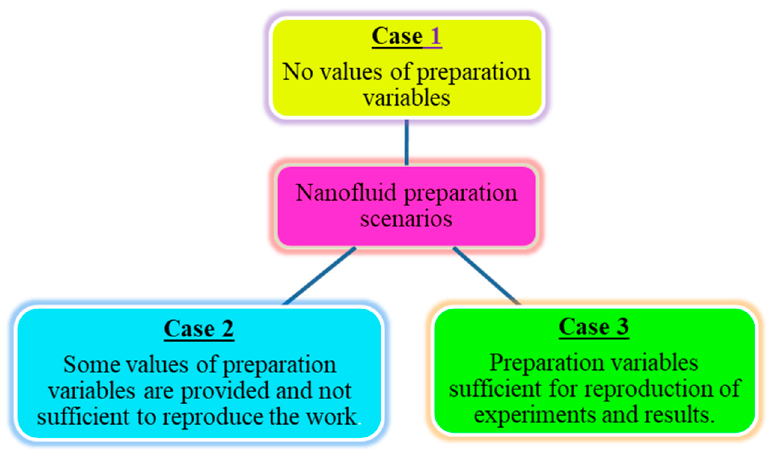
Figure 10. Scenarios portrayed by nanofluid preparation studies.